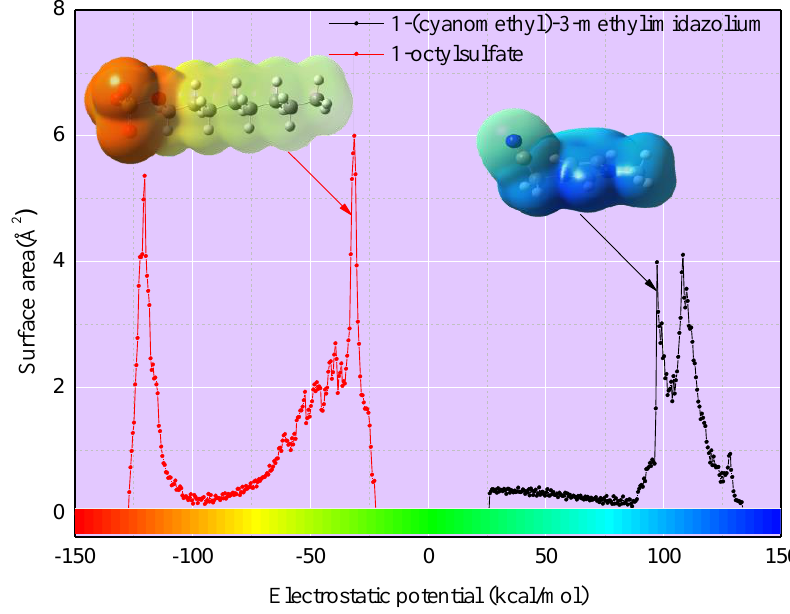
Figure 8. The electrostatic potential surface area ( S EP ) of representative cations and anions of ionic liquids (ILs).